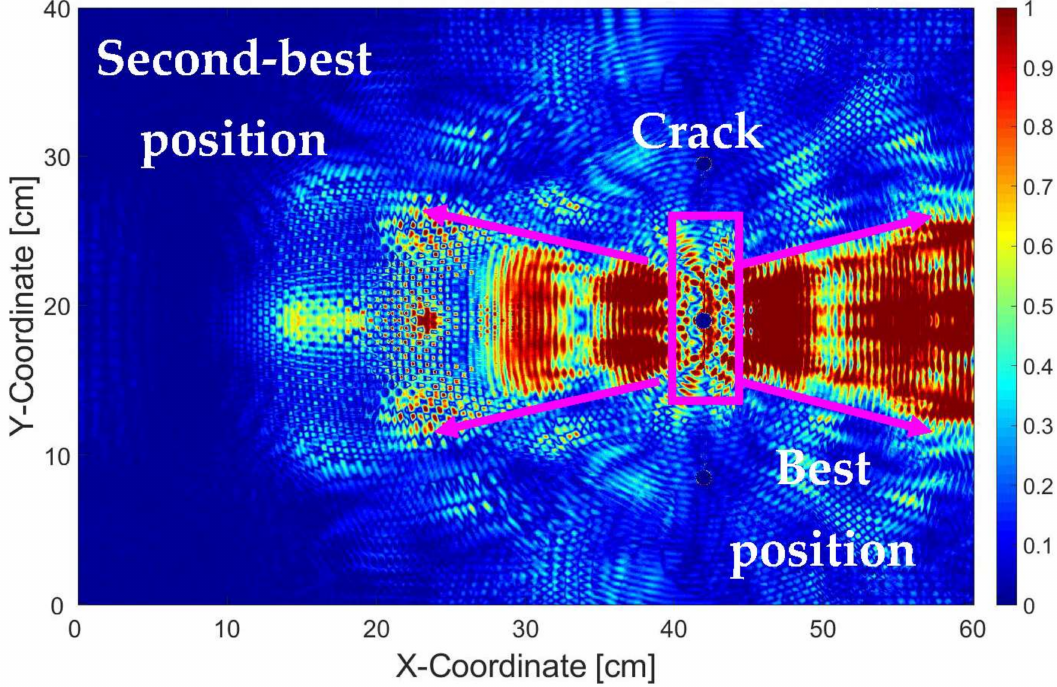
Figure 7. Fused image of Figure